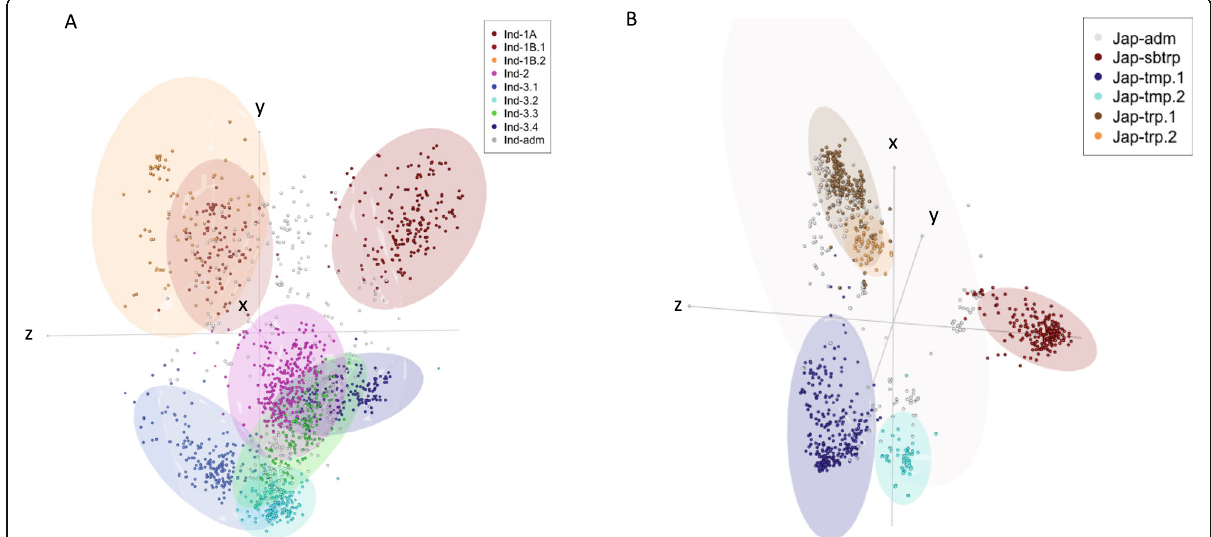
Fig. 3 PCO analysis of Indica and Japonica Vietnamese subpopulations. a PCO analysis of 1605 Indica samples (omitting the samples classified as XI-adm and Ind-adm outside Vietnam for clarity). The ellipses show the 95% confidence interval for the K15_new subpopulations (the K15_3KRGP and five Vietnamese Indica subpopulations are shown in Fig. S5). X = PC1, Y=PC4, Z = PC5. b PCO analysis of 982 Japonica samples (omitting the samples classified as GJ-adm and Jap-adm outside Vietnam for clarity) showing the K15_new subpopulations (the K15_3KRGP and four Vietnamese Japonica subpopulations are shown in Fig. S6) X = PC3, Y=PC4, Z =